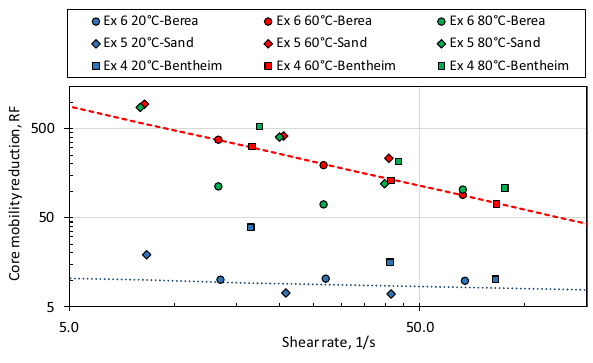
Fig. 14 RF pm with 1000 ppm A10 in SSW as a function of shear rate in the Bentheimer cores in Experiment 4, Sand cores in Experi- ment 5 and Berea cores in Experiment 6. Only the maximum RF pm are plotted. The squares are used for Experiment 4, diamonds for Experiment 5 and circles for Experiment 6. Blue markers are used for 20 °C, red for 60 °C and green for 80 °C. The dashed red line rep- resents the trend at 60 °C and the dashed blue line represents the trend at 20 °C. Note that the y-axis is from 5 to 1500 and the x-axis is from 5 to 150 s −1